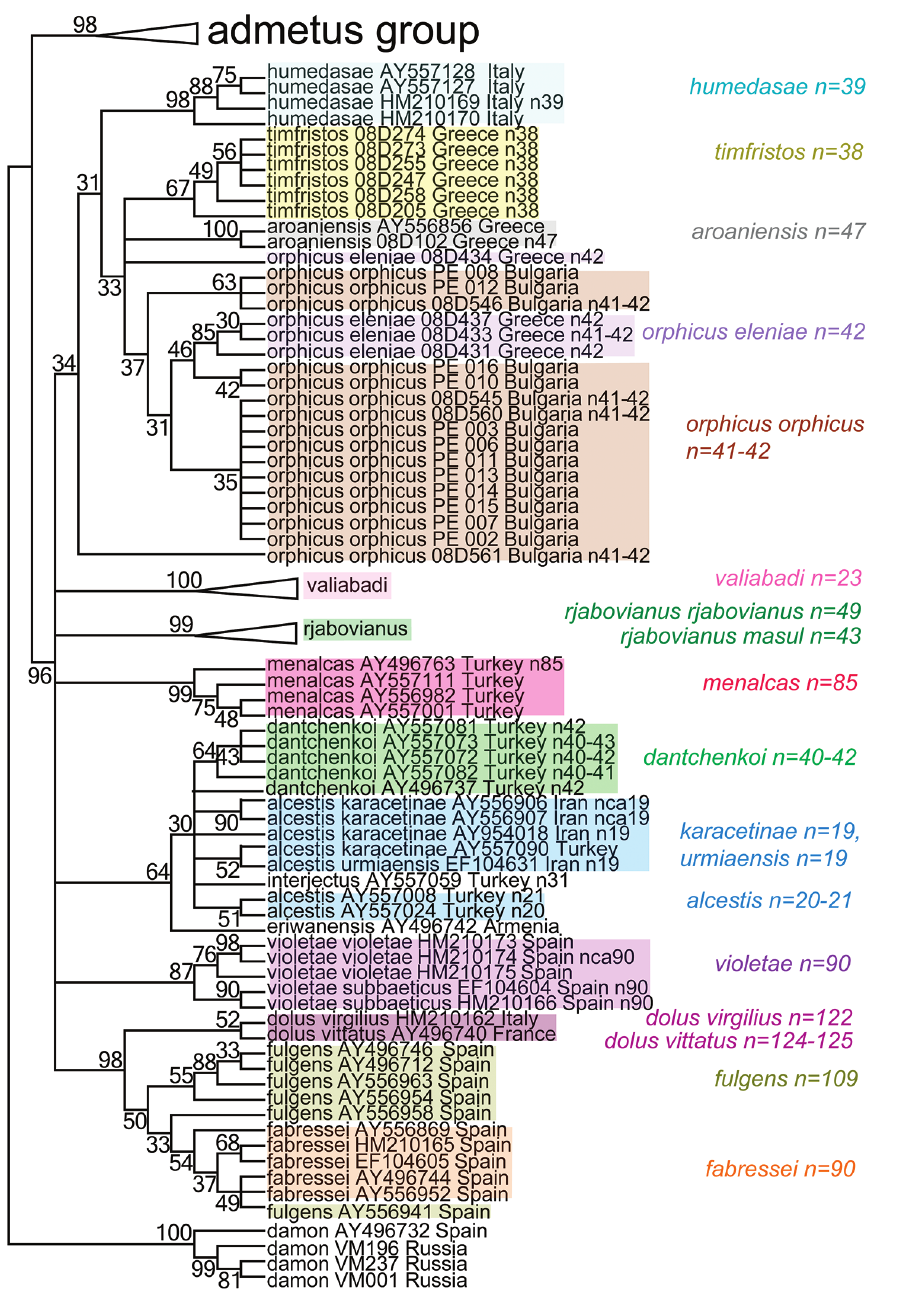
Figure 20. Fragment of the ML tree based on analysis of COI barcodes and focused on details of the P. dolus group. Polyommatus rjabovianus and P. valiabadi clades are not shown in details, for their composi- tion see Lukhtanov et al. (2015a). Numbers at nodes indicate bootstrap